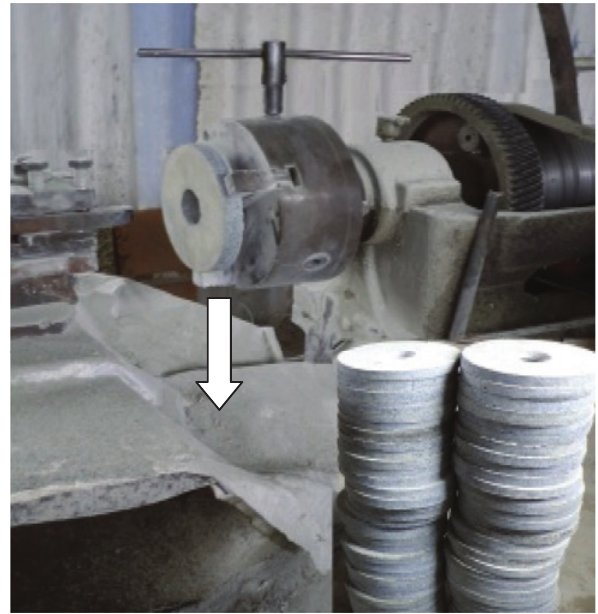
Figure 1: WSD particles indicated as